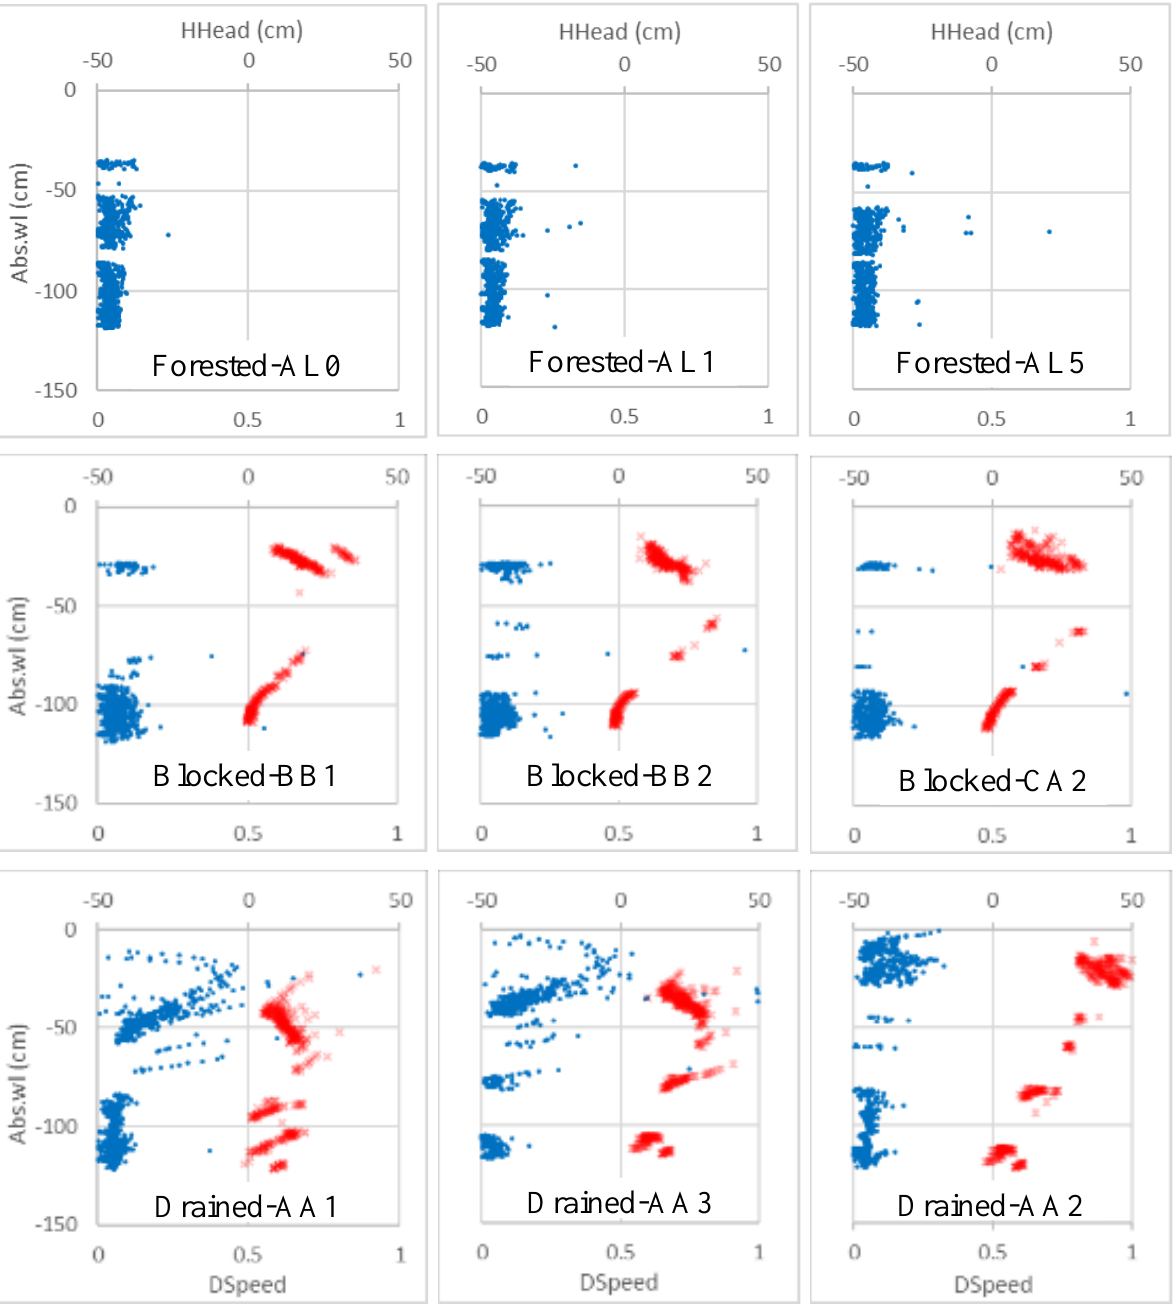
Figure 4. The distribution of standardised water-level drawdown speed (DSpeed) and hydraulic head (HHead) data in Forested, Blocked and Drained. The scattered blue-filled circles are the DSpeed data (left side in each graph). The scattered red crosses are the HHead data (right side in each graph). Negative HHead data indicate that the ditch water level was higher than the well water level at that time. No HHead data were available for